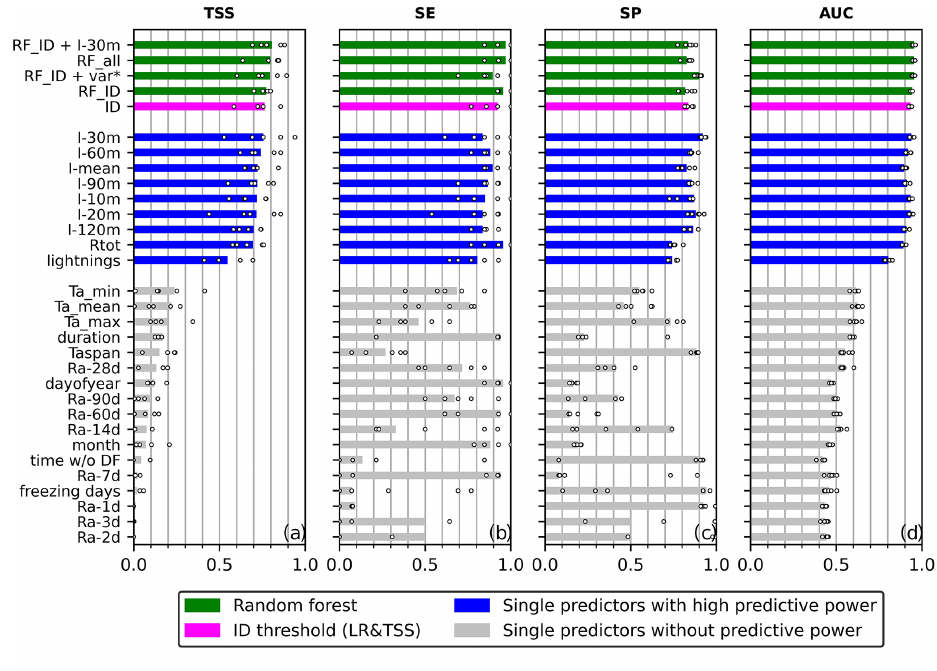
Figure 7. Model comparison (see Table 1) for the prediction of debris flows in the Illgraben catchment, with reference to the (a) true skill statistic (TSS), (b) sensitivity (SE), (c) specificity (SP) and (d) area under the curve (AUC). The threshold for single predictors with predictive powers is set at AUC = 0.65. The bars refer to models using the full data set for training. The dots represent results from the 5-fold cross-validation. The models are sorted top-down with decreasing